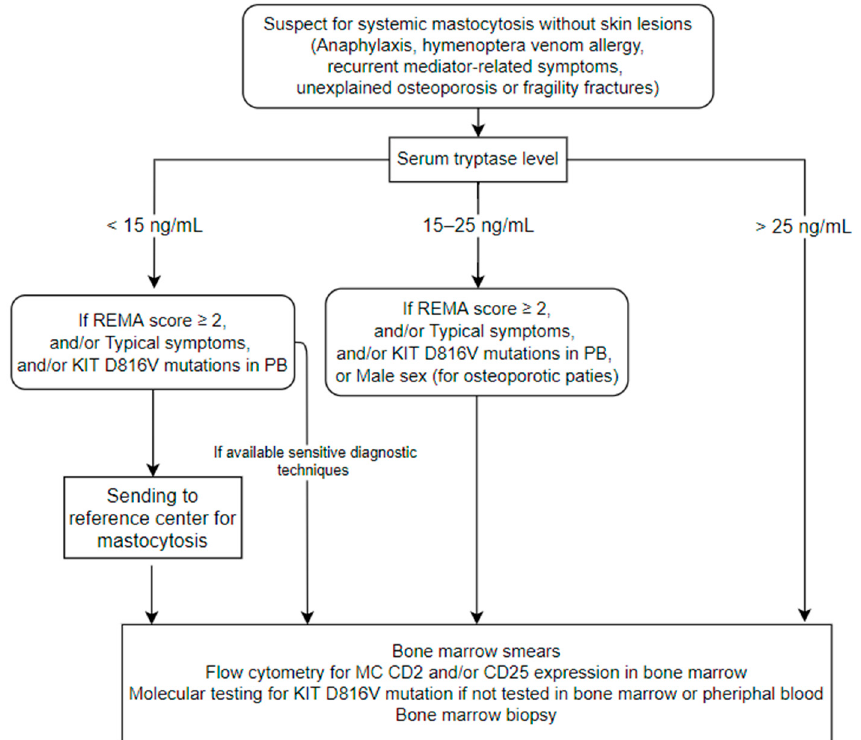
Figure 1. Proposal of diagnostic algorithm in patients with suspicion of Systemic Mastocytosis without typical skin lesions. This figure includes suggestions from both Valent P et al. [16] and Rossini M et al. [32] with some modifications. We used the 3 decision cut-offs of serum tryptase (sT) suggested by Valent et al. (with few differences from those proposed by Rossini et al.) in order to standardize the diagnostic pathway. We included male sex as a criterion only for osteoporotic patients in the cohort with sT between >15 and <25 ng/mL, according to Rossini et al. We also included our personal recommendation of sending patients with sT < 15 ng/mL and with suggested clinical/laboratory characteristics to referral centers if sensitive diagnostic techniques are